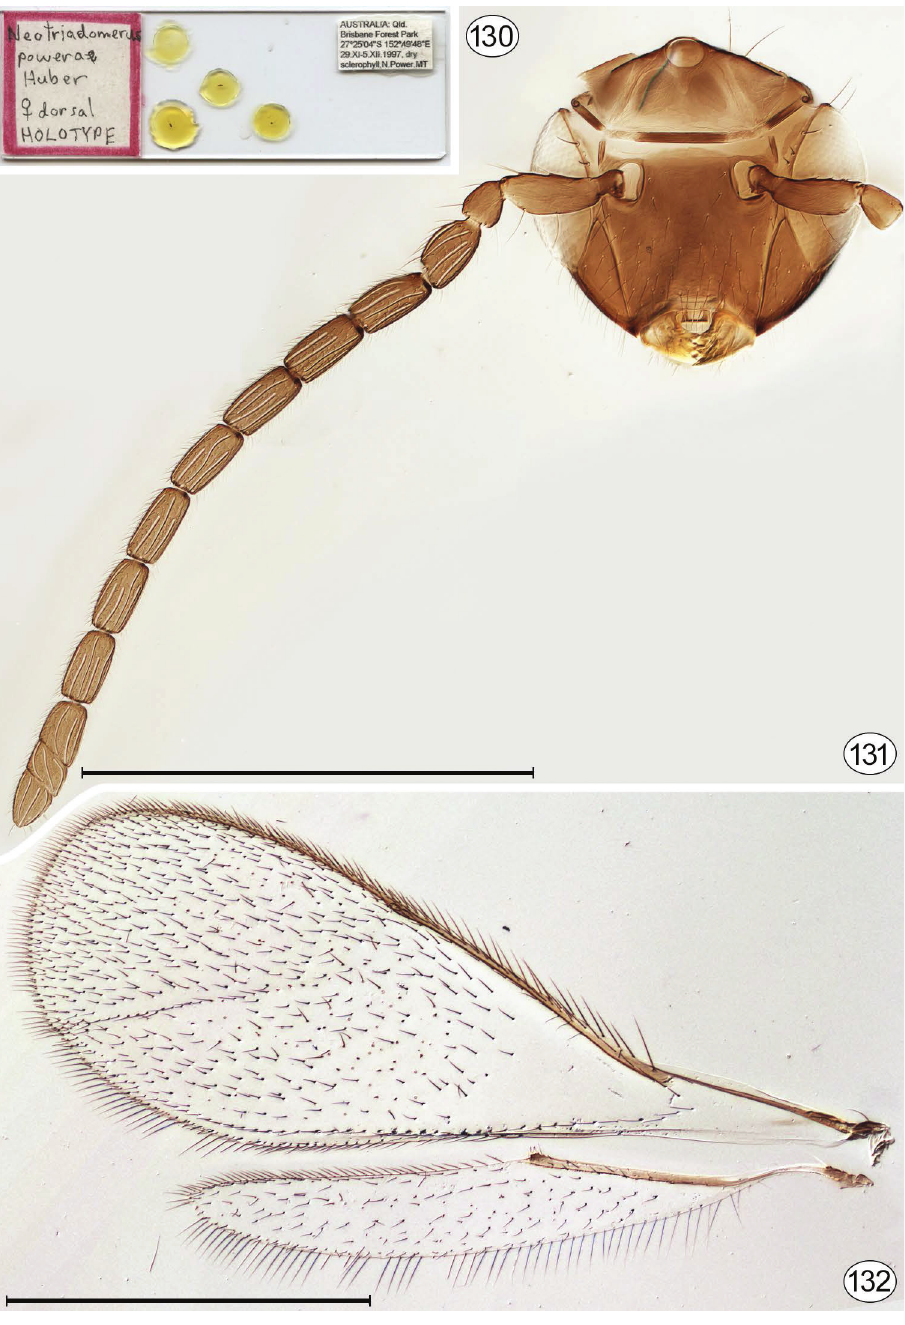
Figures 130–132. Neotriadomerus powerae , holotype. 130 type slide 131 head + antenna, anterior 132 wings. Scale bar = 500